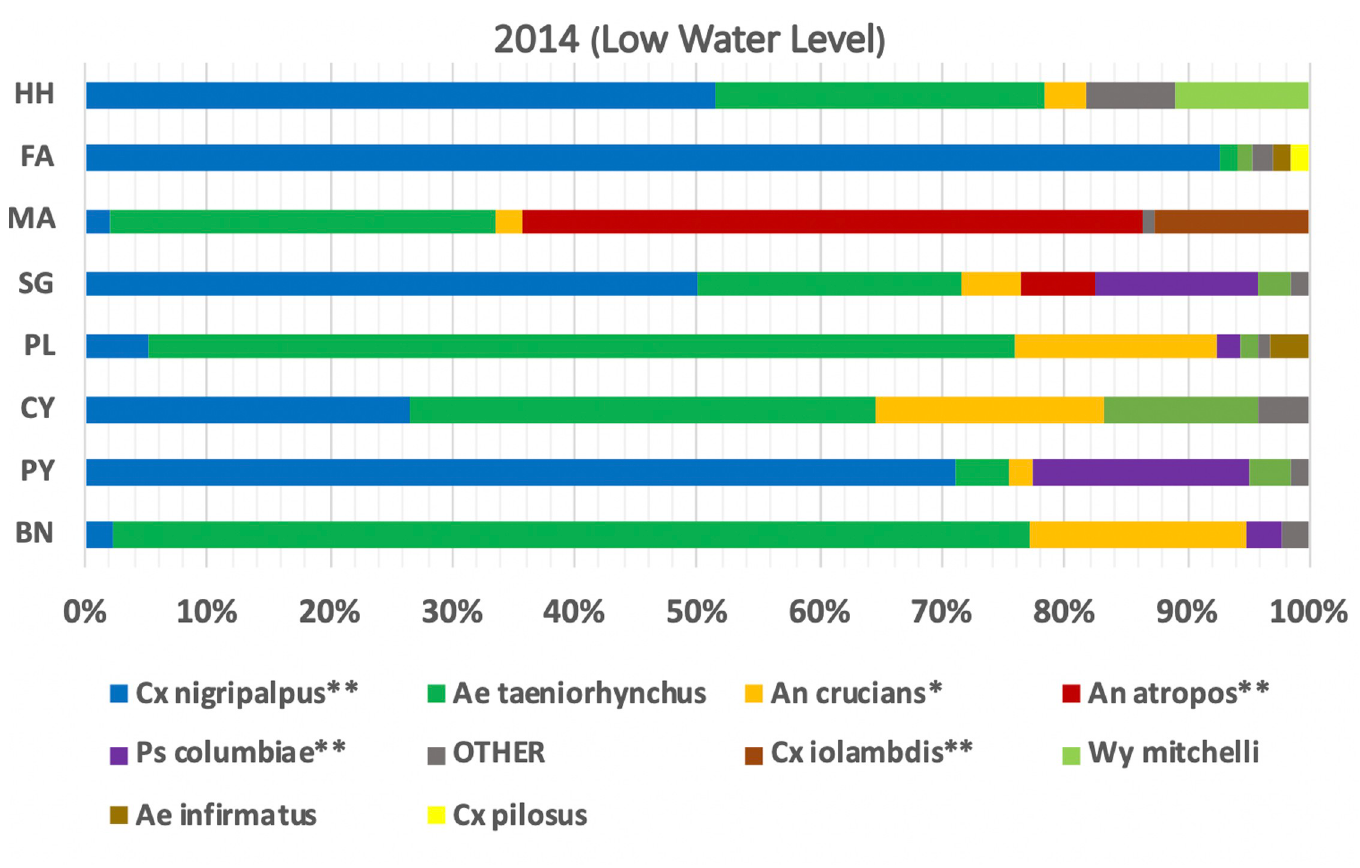
Fig 7. Distribution of mosquito species among landscapes in 2014. Hardwood hammock (HH), Fakahatchee (FA), mangrove (MA), sawgrass (SG), pineland (PL), cypress (CY), Picayune (PY), and burned site (BN). One-way ANOVA levels of significant difference: � P < 0.05, �� P < 0.01.